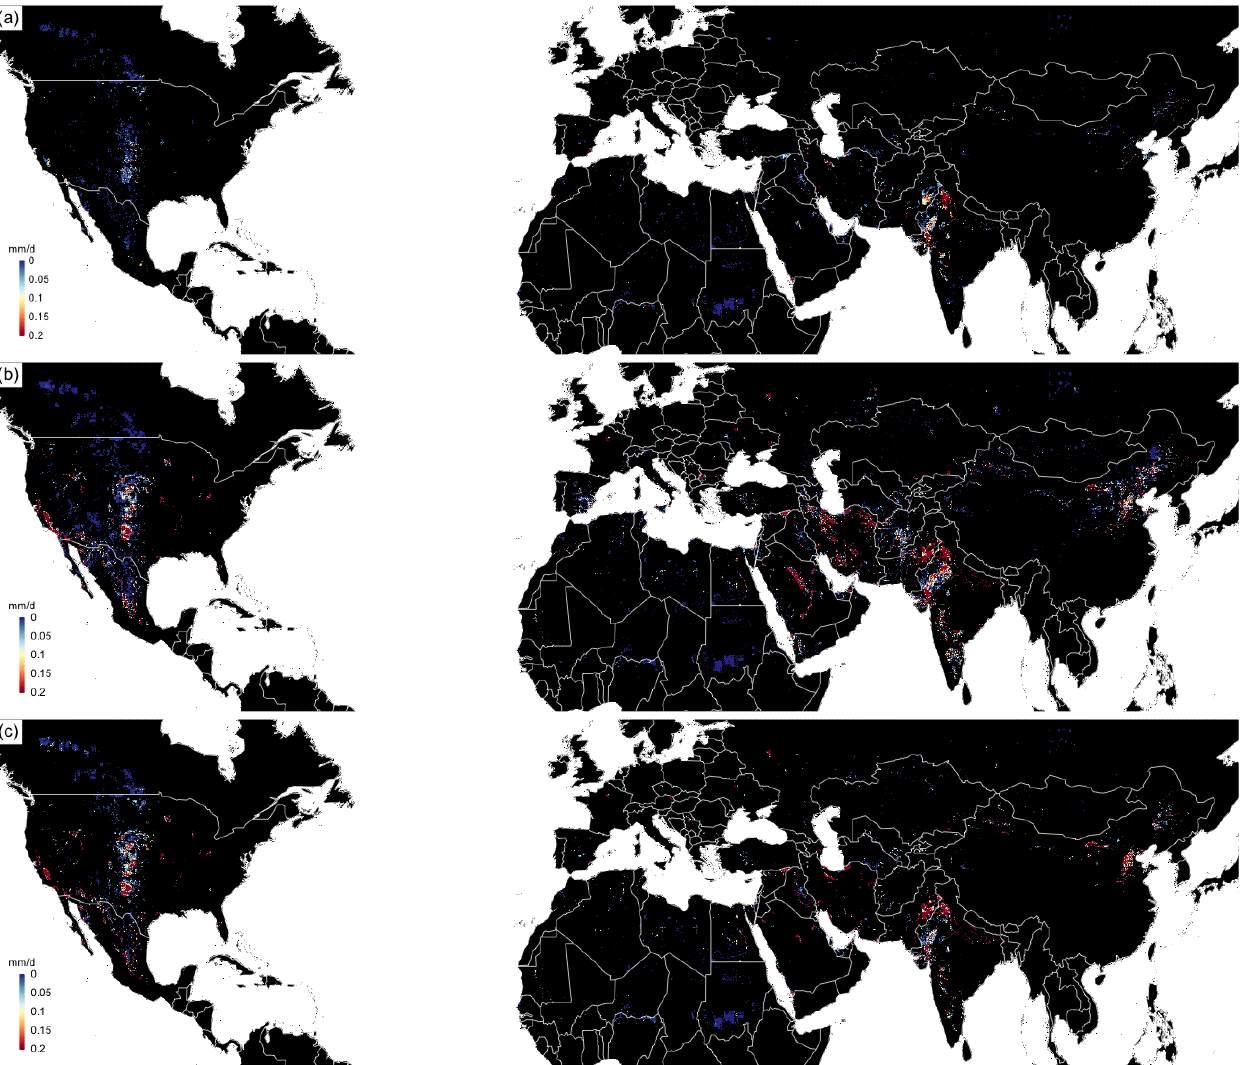
Figure 4. Average groundwater depletion rates ( q − q crit ) over 2000–2015 at 5arcmin resolution calculated with the data from Table 2. (a) Using C values from Sutanudjaja et al. (2018); (b) using C values based on Cuthbert et al. (2019); (c) difference map (a–b)